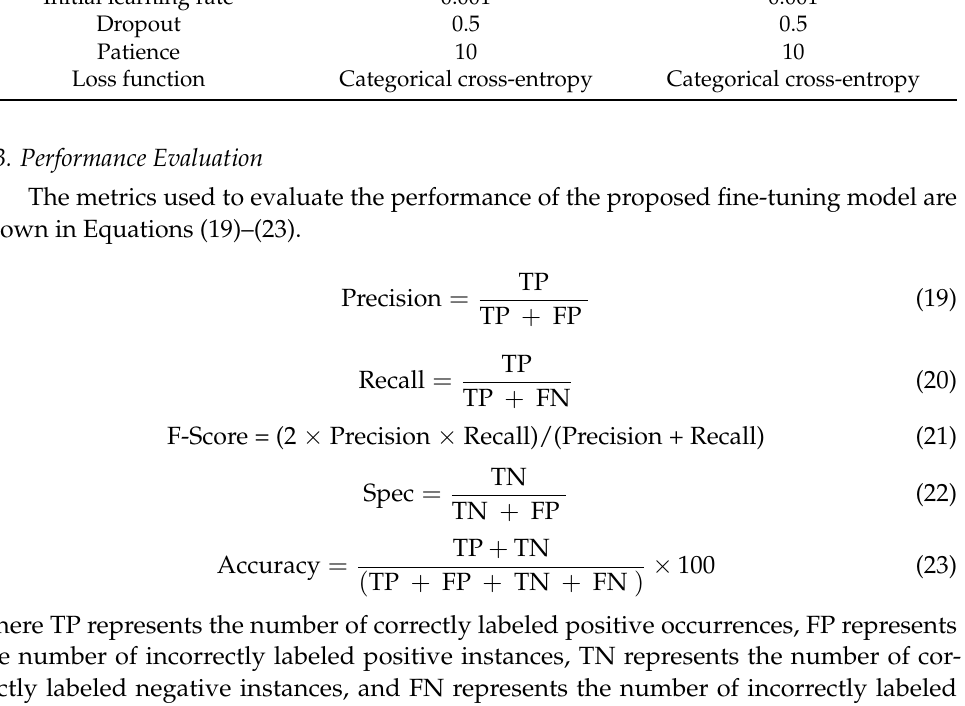
Categorical cross-entropy Categorical